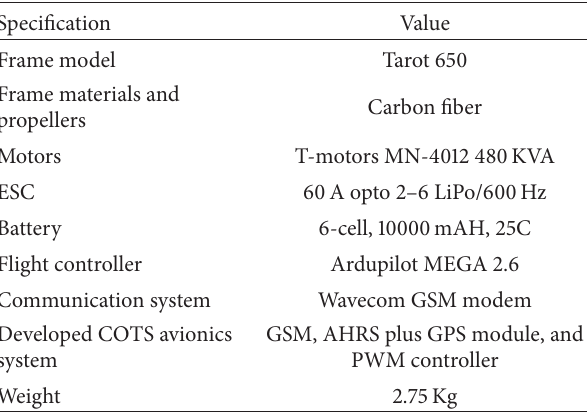
Figure 1: Proposed UAV quadcopter. Table 1: Quadcopter